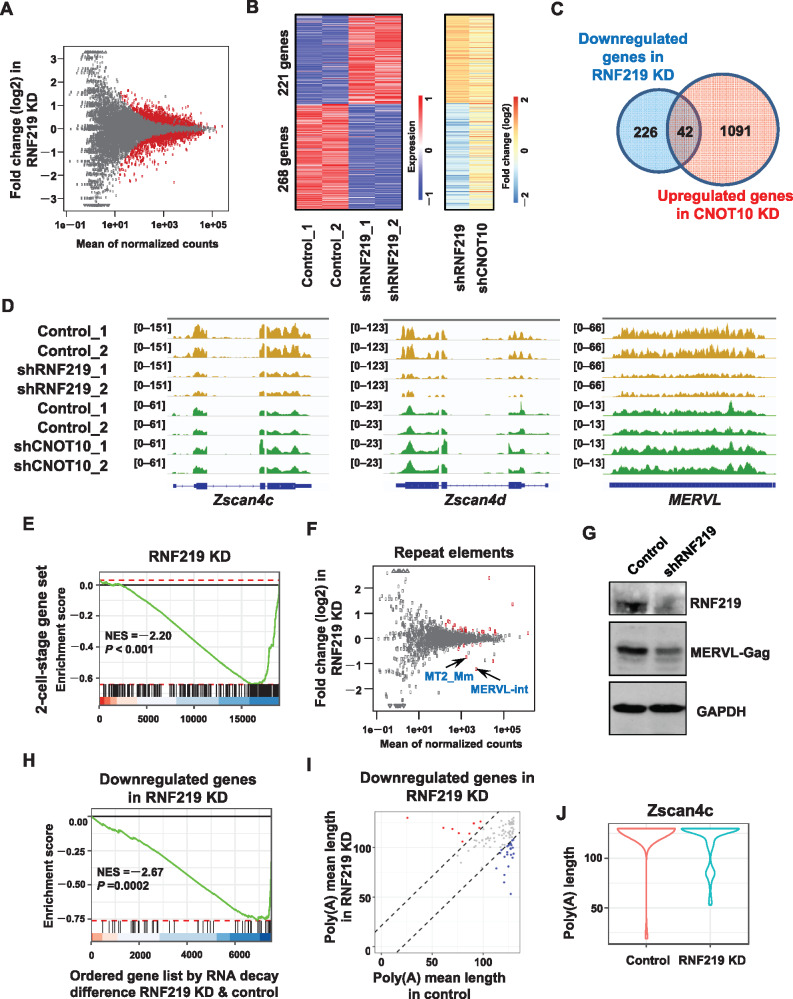
The 2-cell-specific genes are oppositely regulated by RNF219 and CNOT10 in mouse ES cells. (A) MA plot showing differential expression of genes after KD of RNF219 in mouse ES cells. The plot depicts the mean of normalized counts (x-axis) and log2 fold changes that calculated using DESeq2. The red dots represent genes with significance with the adjusted P-value <0.05. (B) Heat maps showing expression levels (left panel) and fold change (right panel) of differentially expressed genes (|Log2FC| > 0.58) in RNF219 KD mouse ES cells. The right panel also showing fold change of these genes in CNOT10 KD mouse ES cells. (C) The Venn diagram depicting the overlap of the downregulated genes after RNF219 KD and the upregulated genes after CNOT10 KD. |Log2FC| > 0.58. (D) Genome browse track file showing that the Zscan4 family and MERVL are downregulated after RNF219 KD but upregulated after CNOT10 KD. (E) GSEA plot showing that the 2-cell-specific genes are highly enriched in the downregulated genes after RNF219 KD in mouse ES cells. (F) MA plot showing differential expression of repeat elements after KD of RNF219 in mouse ES cells. The plot depicts the mean of normalized counts (x-axis) and log2 fold changes that calculated using DESeq2. The red dots represent repeat elements with significance with the adjusted P-value <0.05. (G) Western blot showing the protein level of MERVL-Gag reduced after RNF219 KD in mouse ES cells. (H) GSEA plot showing that transcripts whose levels are maintained by RNF219 tend to be destabilized after RNF219 KD. (I) The scatter plot representing the geometric mean poly(A) tail length in control and RNF219 KD cells, as measured by mTAIL-seq, showing only the genes downregulated after RNF219 KD. (J) The violin plots showing the distribution of poly(A) tag length of Zscan4c in control and RNF219 KD cells.